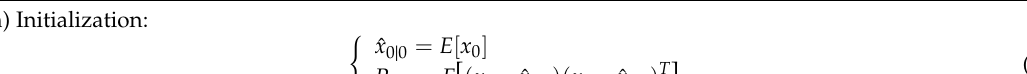
Table 2. The process of SOC estimation based on the square root cubature Kalman filter (SRCKF)